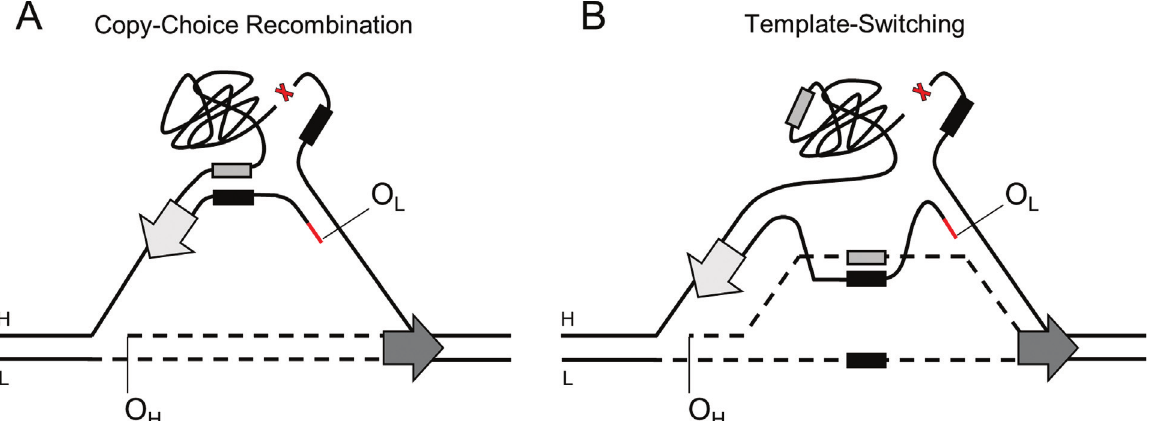
Figure 5 - Schematic representation of the mechanisms of mtDNA deletion formation via copy-choice recombination (A) or template-switching (B). In both scenarios, DNA synthesis of the light-strand initiated at O L , using the heavy-strand template (denoted as H), is stalled after the 5’ deletion’s flanking region (black box), which promotes template breaking (indicated with a red X) between the deletion flanking regions. The 5’ flanking region of the na- scentlight-strandmaypairwiththecomplementary3’flankingregionoftheparentalheavy-strand(graybox),whichwouldenablereplicationrestart(A). Alternatively, the nascent light-strand may invade the nascent heavy-strand (which remains paired with the parental light-strand, denoted as L; both strands represented as dashed lines), and pair with its complementary 3’ flanking region (gray box). Such a duplex structure would serve as a transient primed-template for DNA synthesis, until the damage site is bypassed and replication can resume on the parental heavy-strand (B). The block arrows rep- resent the replisome progressing in the indicated directions during heavy- (dark gray) and light- (light gray) strand syntheses. The red line represents an RNA primer generated at O L